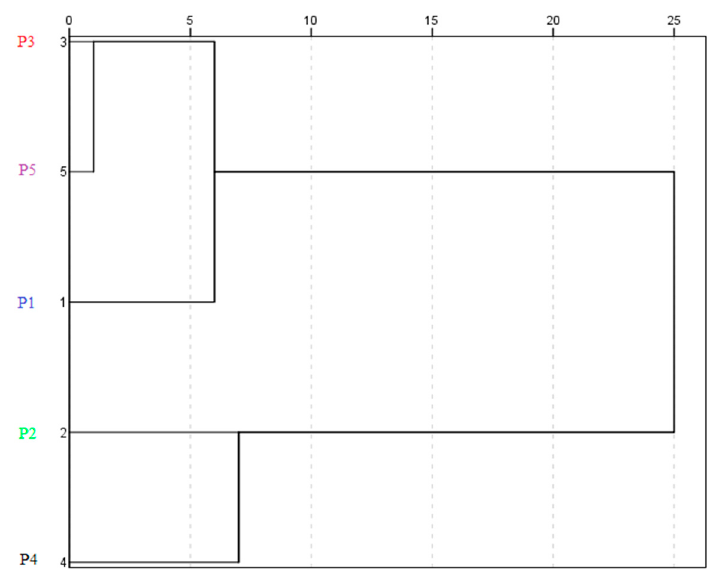
Figure 8. Hierarchical cluster analysis for the A. unedo accessions